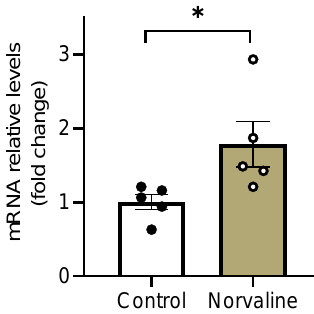
Figure 4. Hippocampal CCL11 mRNA expression levels. Real-time polymerase chain reaction (RT-PCR) analysis of mRNA levels of CCL11 gene. The normalized data are presented as the mean ± SEM ( n = 5 brains per group). * p < 0.05 (two-tailed Student’s t -test).